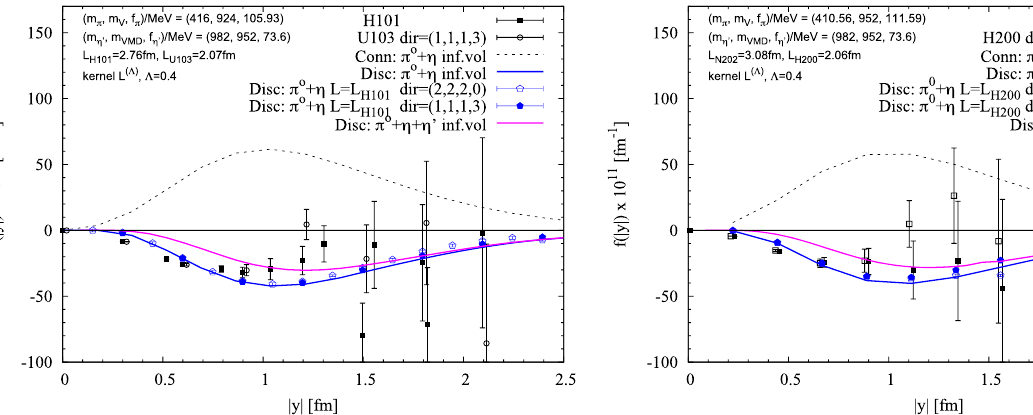
Fig. 12 Integrand for the disconnected contribution on ensembles H101 and U103 (left), as well as N202 and H200 (right). The lattice data are shown as black points. The black dashed line shows the fully-